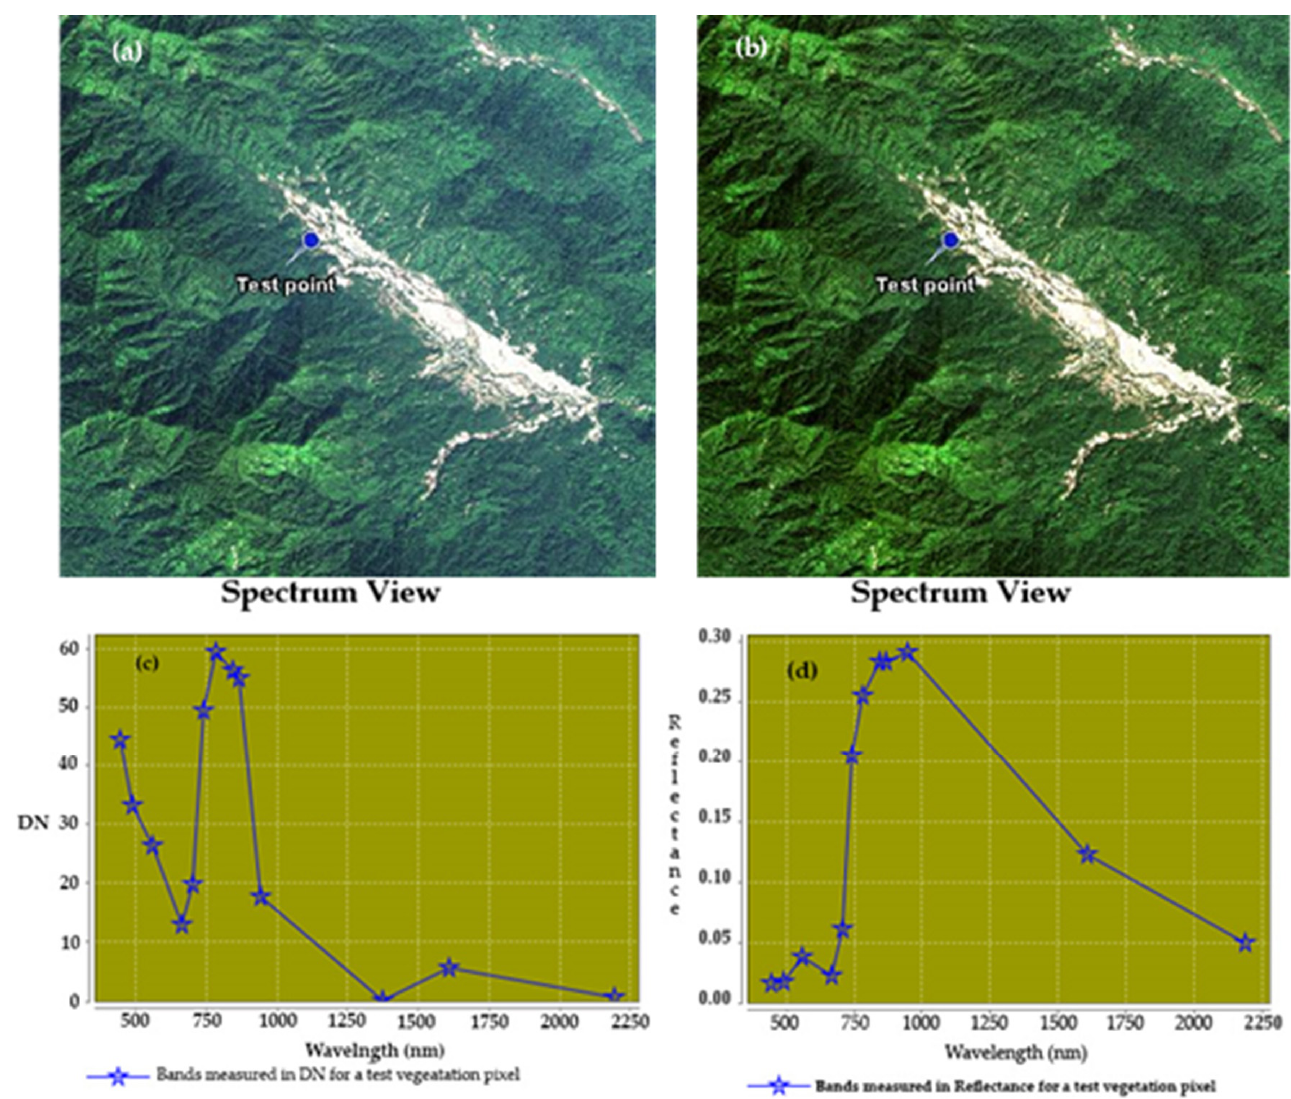
Figure 2. The original Sentinel-2 L1C image ( a ) and atmospherically corrected image L2A ( b ), and the original ( c ) and corrected ( d ) spectral curves for a test vegetation pixel.